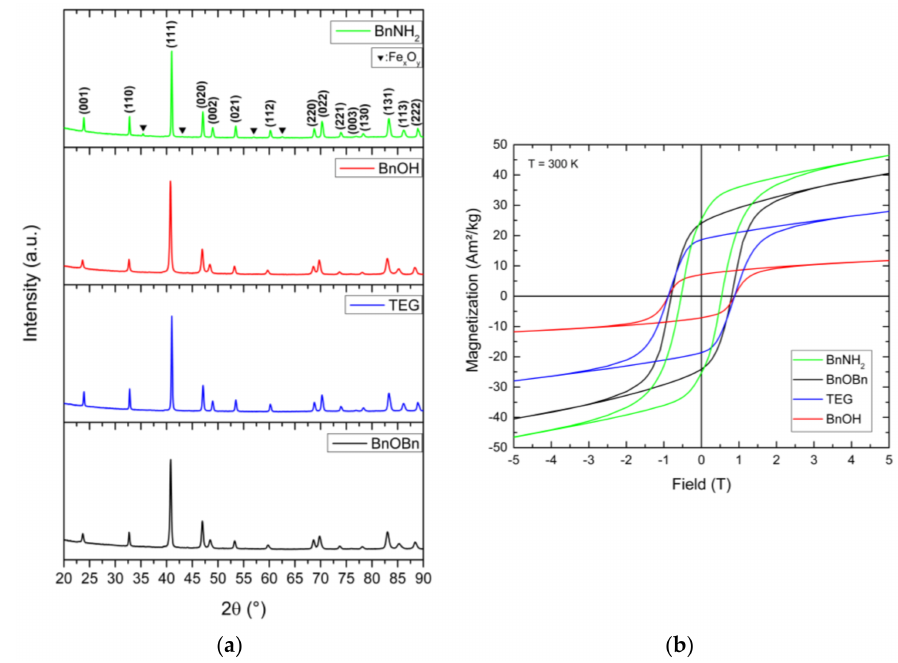
Figure 7. Diffraction patterns of the fct-FePt nanoparticles obtained after annealing at 800 ◦ C ( a ) and superconductive quantum interference device (SQUID) measurements of the hard-magnetic properties of the generated ordered L1 0 phase ( b ) for the different reaction systems (non-corrected curves).